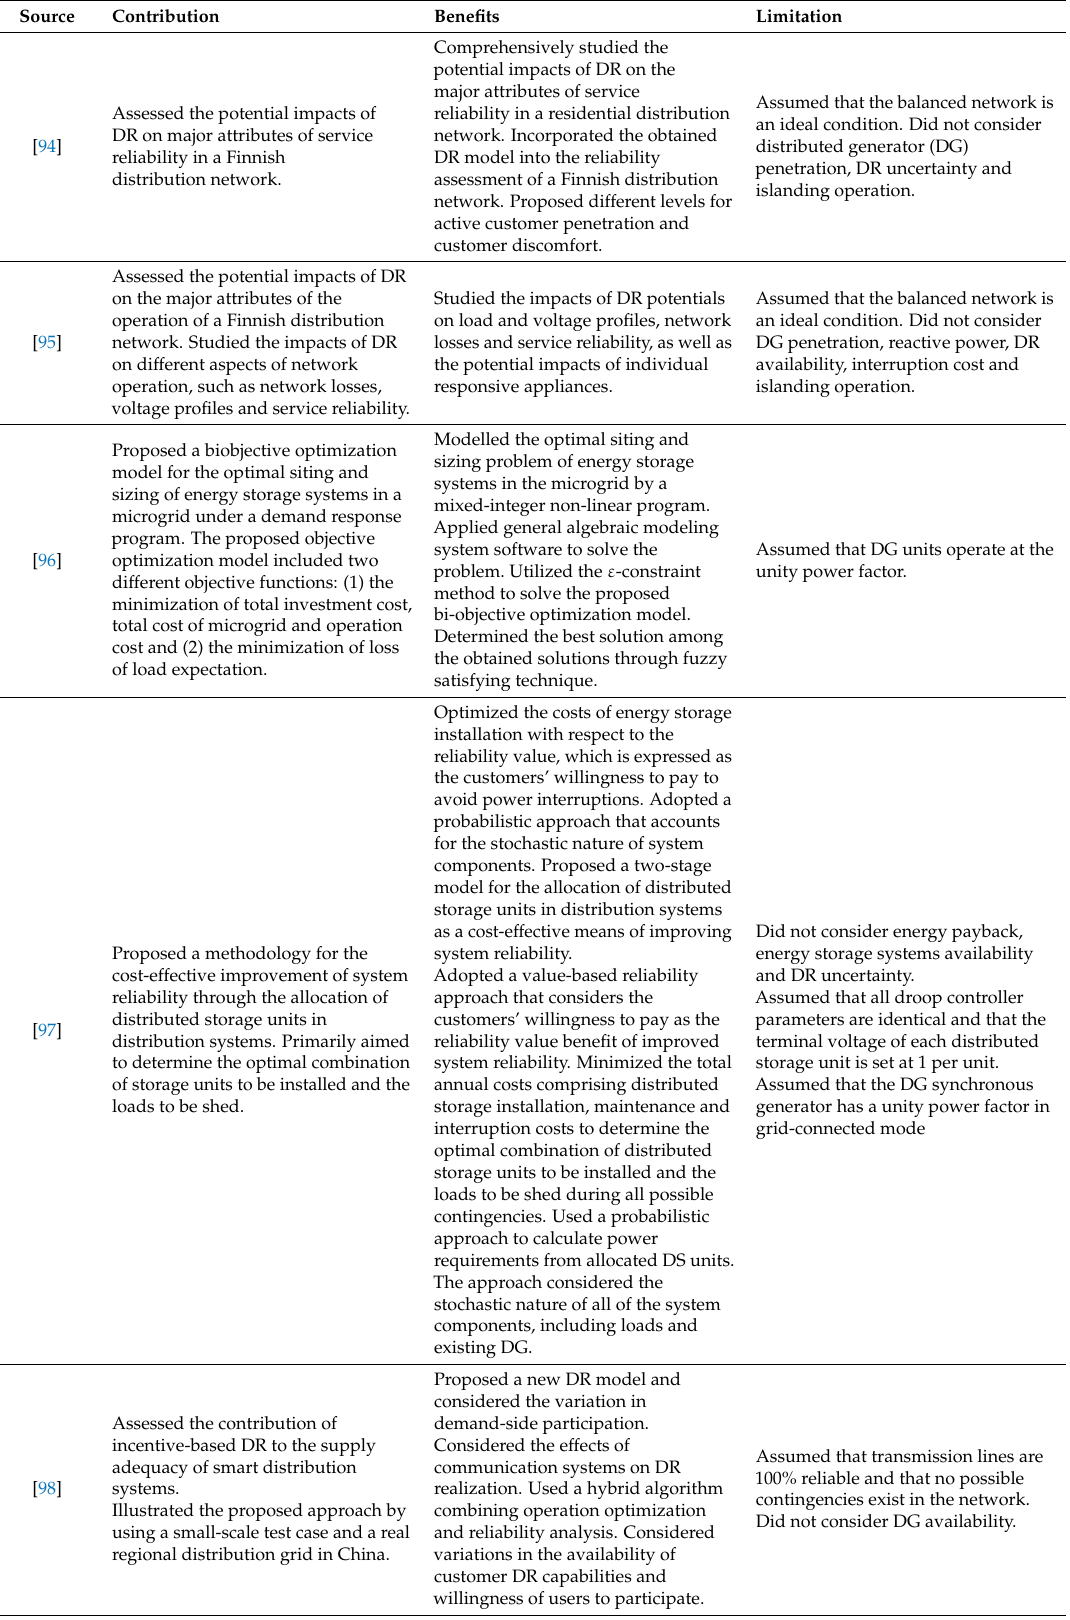
Table 3. Comparison of notable works on the impacts of DSM on distribution